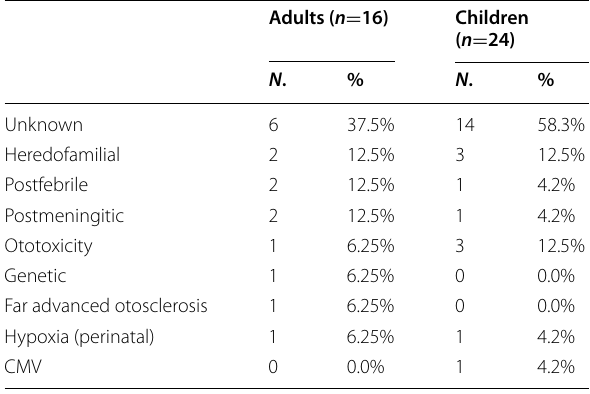
Table 2 Distribution of the study group according to etiology of hearing